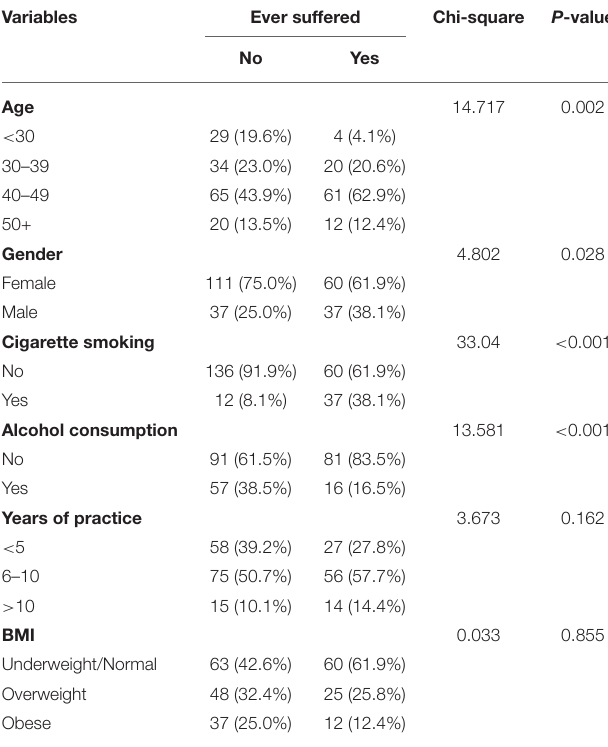
TABLE 2 | Bivariate analysis of individual factors associated with LBP.